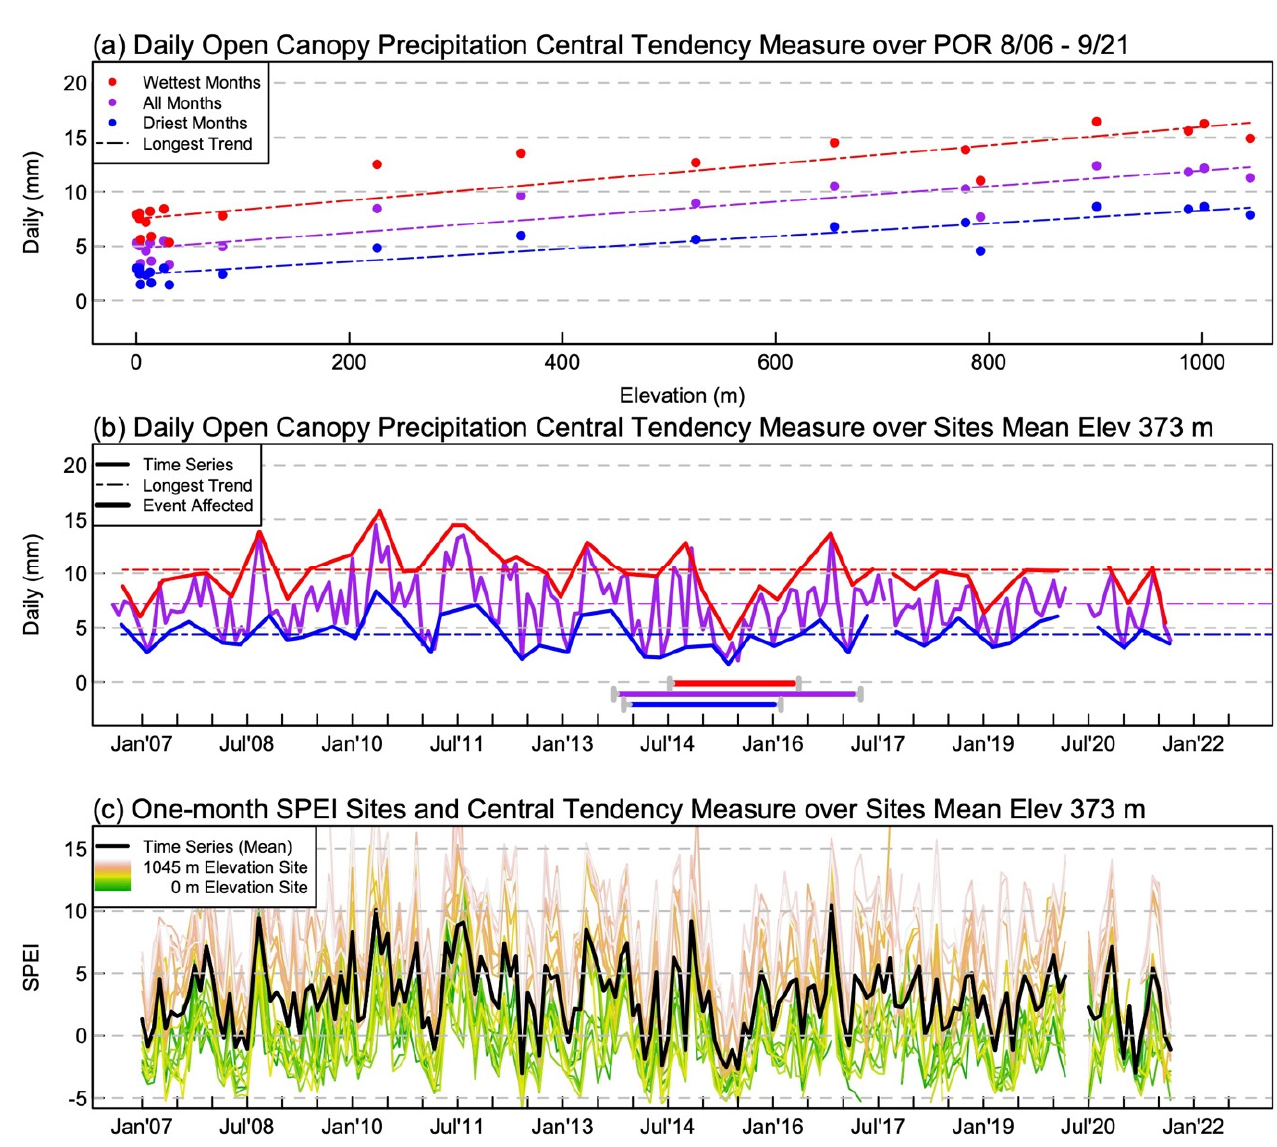
Figure 5. Average of the statistical calculations on the open-canopy precipitation for wettest months, all months, and driest months. Plot ( a ) shows the site period of record average values as points with the trend lines of magnitude with elevation. Plot ( b ) shows the periodic component timeseries (“all months” have period 1 month and “wettest” and “driest” have period 4 months) averaged over the sites as thick lines, with thin dashed trend lines of magnitude with time at the average site elevation (373 m). The colors signify the same variable across the plots ( a , b ). Only the longest trend calculated is shown, from the entire record. The estimated event-affected (drought) periods are shown in thick bars on the bottom of plot with the gray part of the bars as the 90% confidence intervals around the end points. Plot ( c ) shows the 1 month Standardized Precipitation–Evapotranspiration Index (SPEI) calculated at each site (colored lines) and the average of these sites (black line).